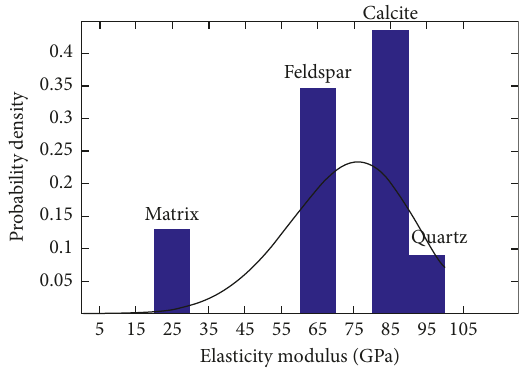
Figure 7: Fitting the Weibull distribution function to the prob- ability density-Young modulus diagram.